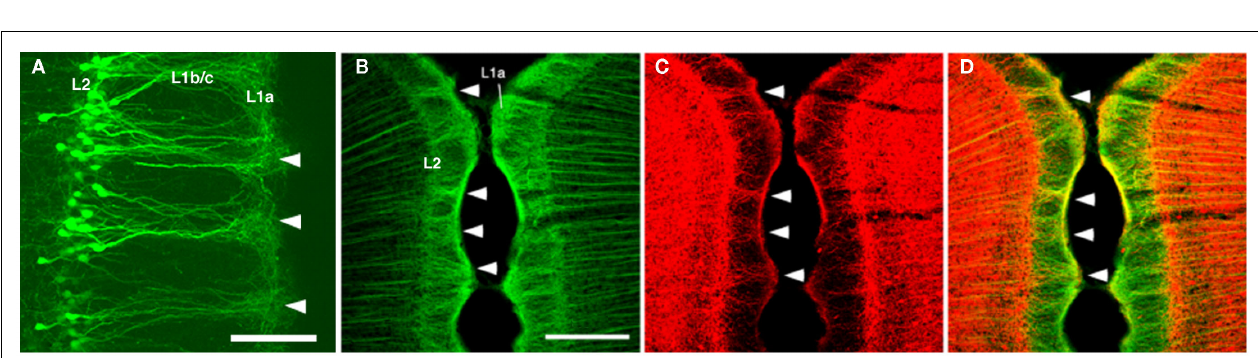
double-immunofluorescence for microtubule-associated protein 2 (MAP2; green) and parvalbumin (PV; red). Coronal sections. Scale bar: (A) , 50 μ m; (B–D) , 200 μ